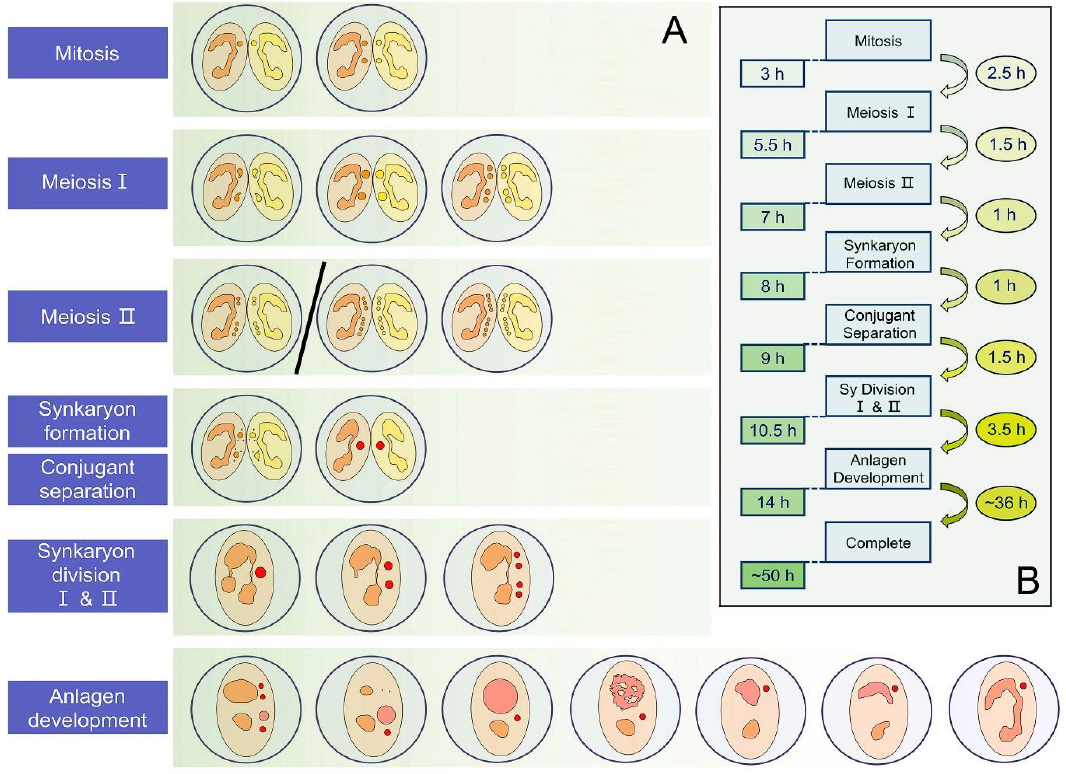
Figure 4. Summary of the nuclear events occurring during conjugation in Euplotes raikovi . ( A ) Schematic diagrams showing the nuclear events at each step of conjugation. ( B ) Time chart of each step of conjugation. The initial formation of mating pairs was taken as time 0 of the process. The number on the left indicates the time point from initial pair formation. The number on the right indicates the time taken by each step.